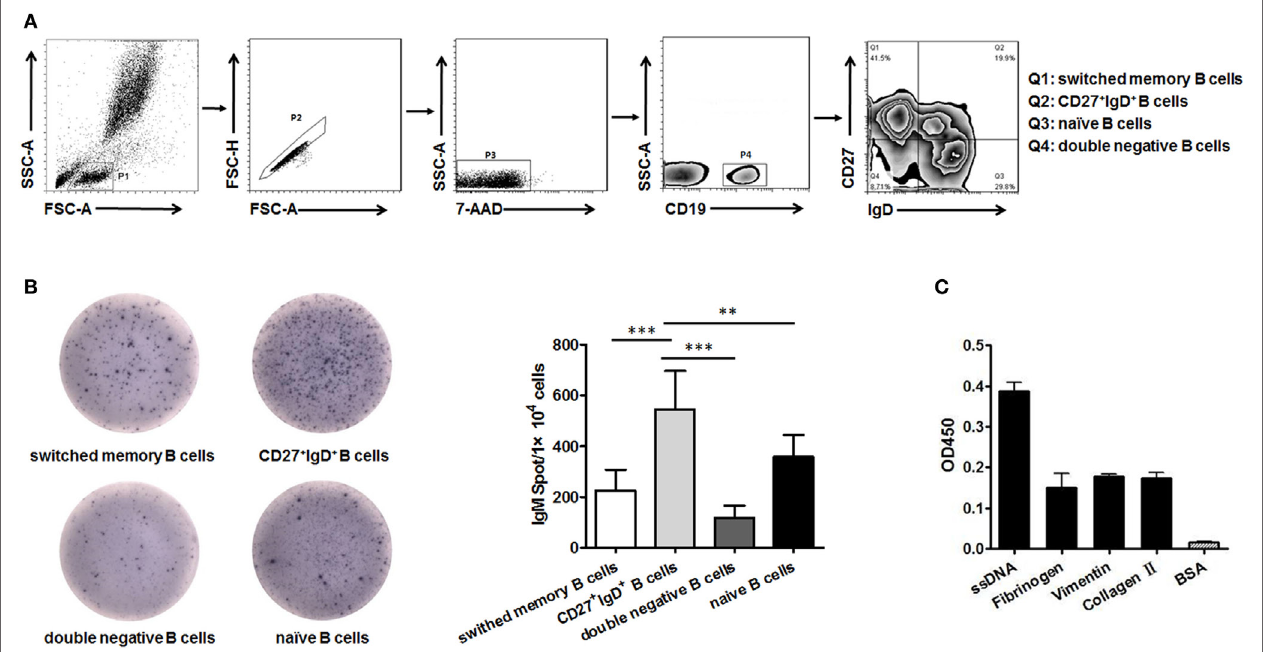
FigUre 1 | Human CD27 + IgD + B cells could produce natural antibody-like IgM. (a) Gating strategy for identifying CD27 + IgD + B cells (Q2) as well as double negative B cells (Q4, CD27 − IgD − ), naïve B cells (Q3, CD27 − IgD + ), and switched memory B cells (Q1, CD27 + IgD − ) according to CD27 and IgD expression. (B) CD27 + IgD + B cells as well as the other three B cell subsets were sorted from healthy volunteer peripheral blood ( n = 5) by flow cytometry, and then were subjected to IgM ELISPOT analysis (one-way ANOVA, ** P < 0.01, *** P < 0.001). (c) Flow cytometry-sorted healthy volunteer CD27 + IgD + B cells ( n = 5) were cultured in vitro for 3 days in the presence of anti-CD40 (3 µg/ml) and CpG (10 µg/ml), then the cell culture supernatants were collected for polyreactivity ELISA against different rheumatoid arthritis autoantigens, including ssDNA, fibrinogen, vimentin, and collagen II. BSA was chosen as the control. The results were presented as mean ±